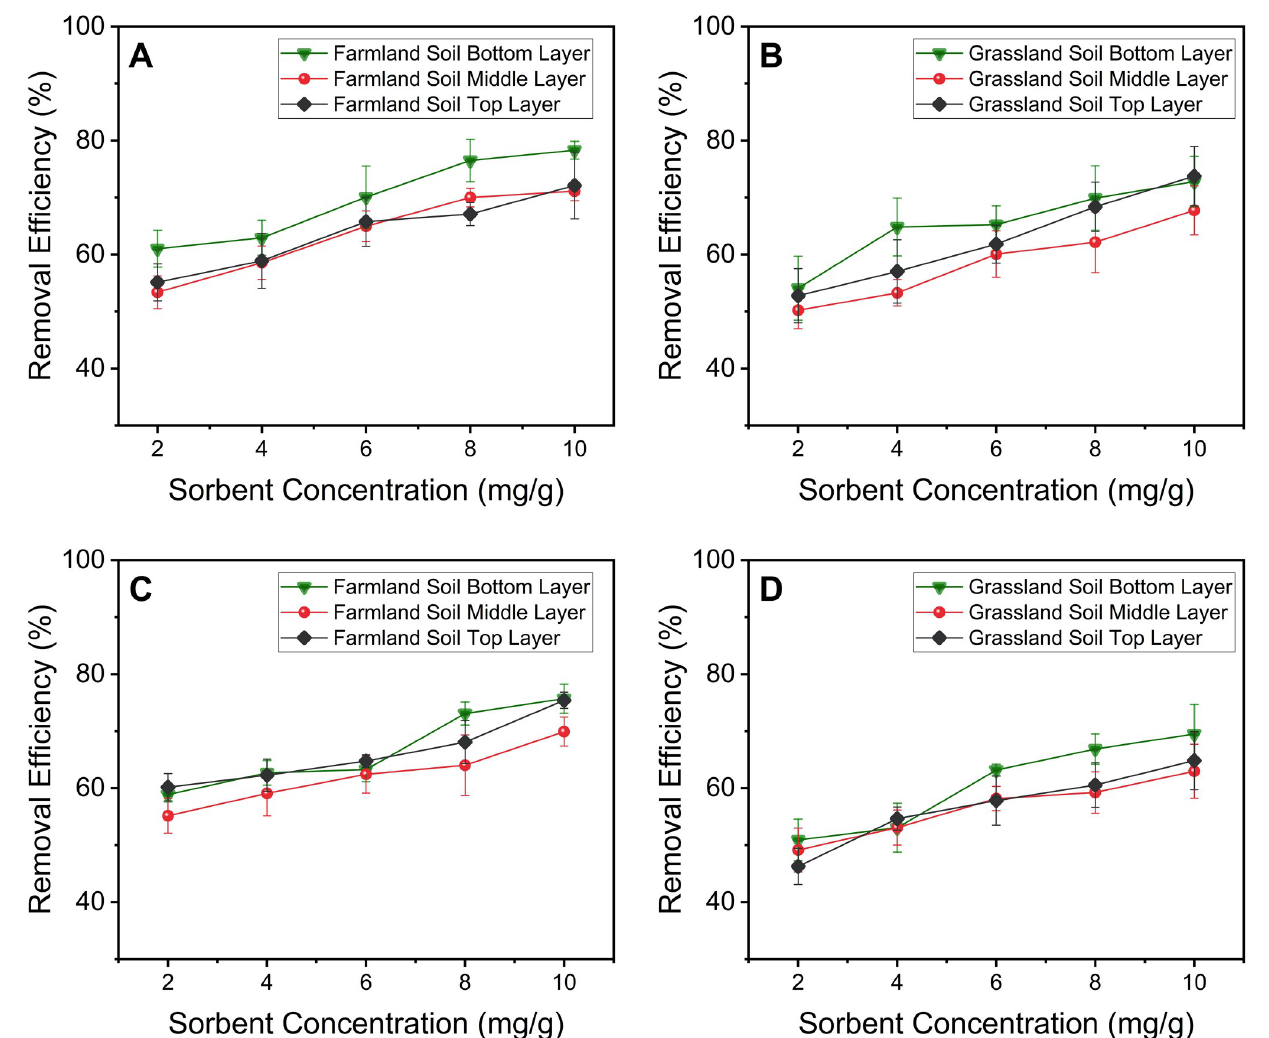
Fig 5. Removal efficiencies using Ligand DNPs for (A) Pb 2+ contaminated farmland soil; (B) Pb 2+ contaminated grassland soil; (C) Cd 2+ contaminated farmland soil; (B) Cd 2+ contaminated grassland soil. The data was collected across different vertical soil